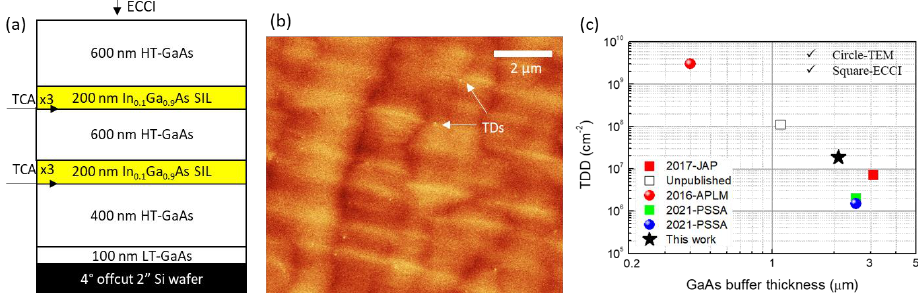
Figure 1. ( a ) GaAs buffer structure on 4-degree offcut Si using In 0.1 Ga 0.9 As single insertion layer and thermal cycle annealing. ( b ) An ECCI image of the GaAs buffer surface grown on Si substrate. ( c ) Threading dislocation density benchmark of GaAs/Si materials reported by other groups.